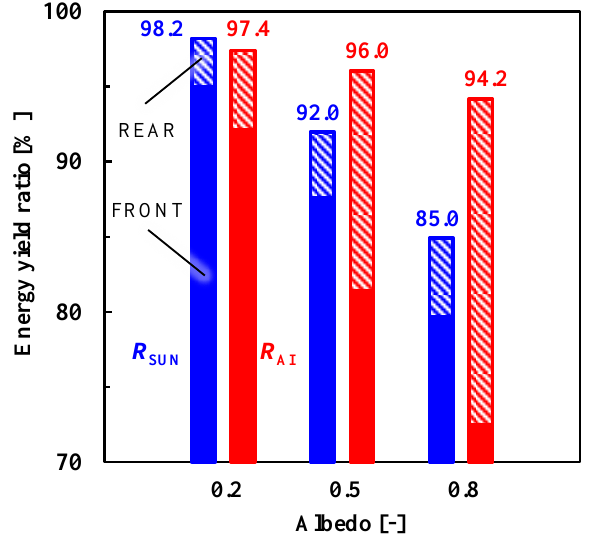
Figure 8. Stacked bar graph of 5-year energy-yield ratio averaged over RUNs 1–10 with breakdowns of front and rear contributions.